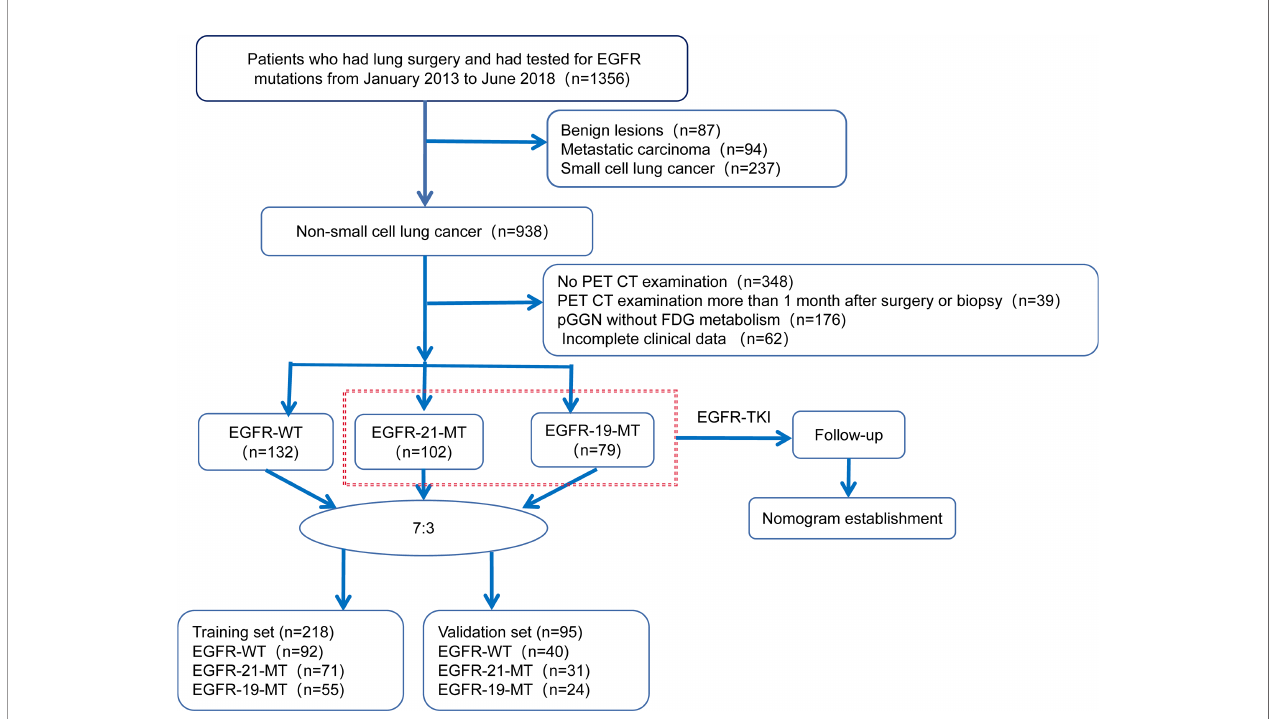
FIGURE 1 | Study design and patient